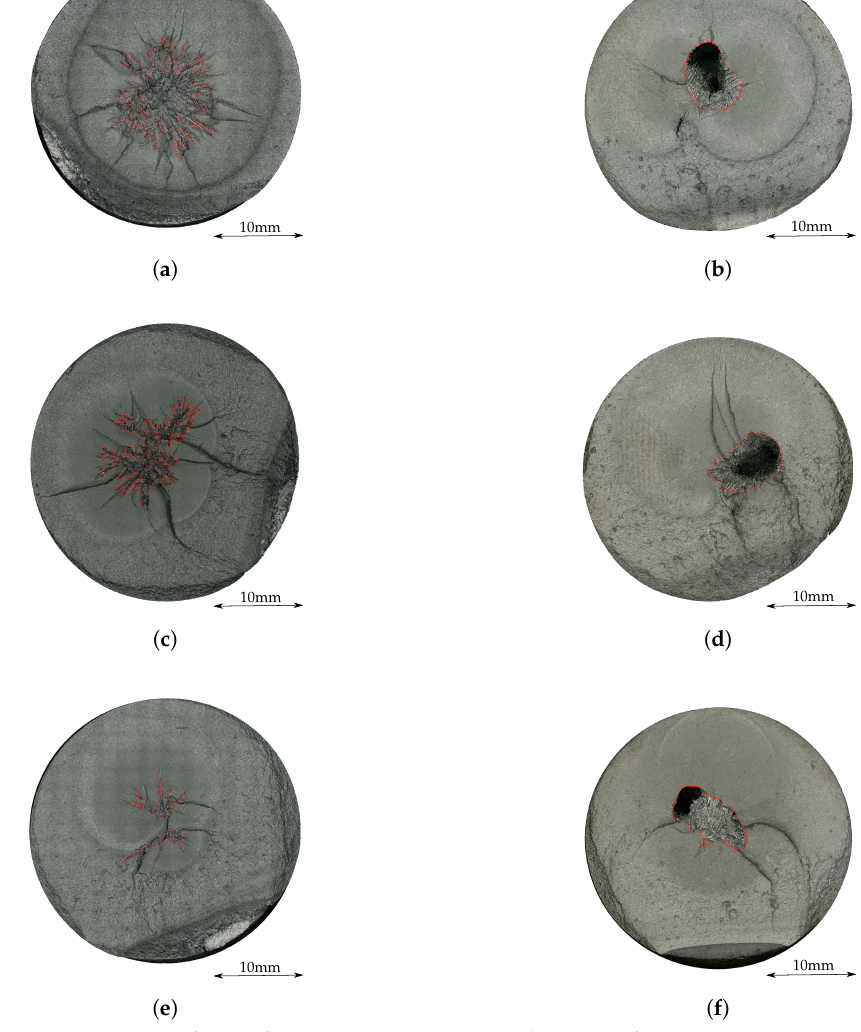
Figure 16. Fracture surfaces of representative FT#A and FT#B defects. ( a ) FT#A Specimen #10 ( b ) FT#B Specimen #29 ( c ) FT#A Specimen #11 ( d ) FT#B Specimen #30 ( e ) FT#A Specimen #13 ( f )